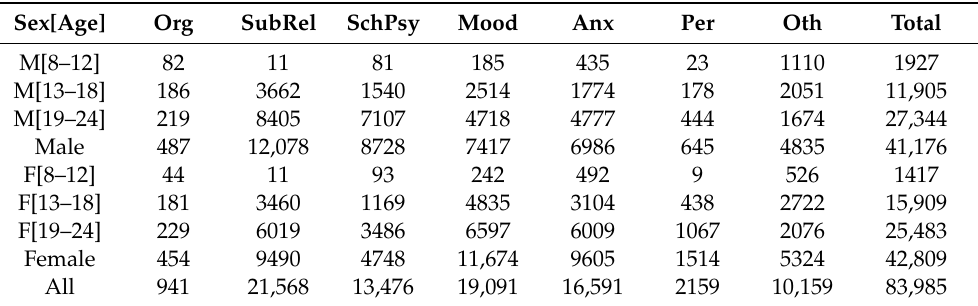
Table 1. Emergency department (ED) visits by type of health problem, sex, and age group. Toronto, Canada,